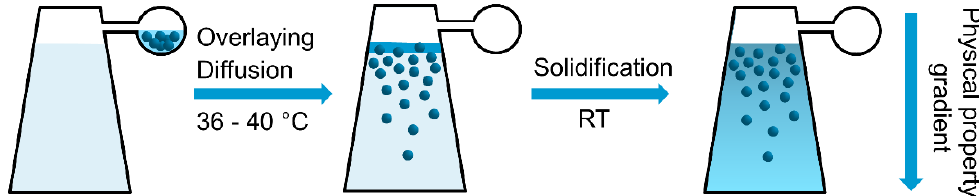
Figure 1. Schematic view of the preparation of a nanoparticle gradient material in the sample sector of an analytical ultracentrifugation band-forming cell. The nanoparticles (blue spheres) are overlaid at low rotational speed and diffuse into the molten gelatin gel. After achieving the desired nanoparticle concentration gradient, the cell is cooled to room temperature to solidify the gelatin and fix the gradient in the gel phase. A physical property gradient inside the material is obtained.